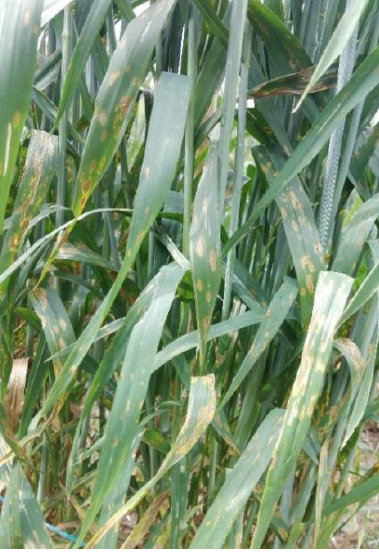
Figure 2. Typical tan spot symptoms in the field at the adult stage corresponding to GS55 at the Septoria Precision Phenotyping Platform (Experimental station of Koudia, Bou Salem, Tunisia).